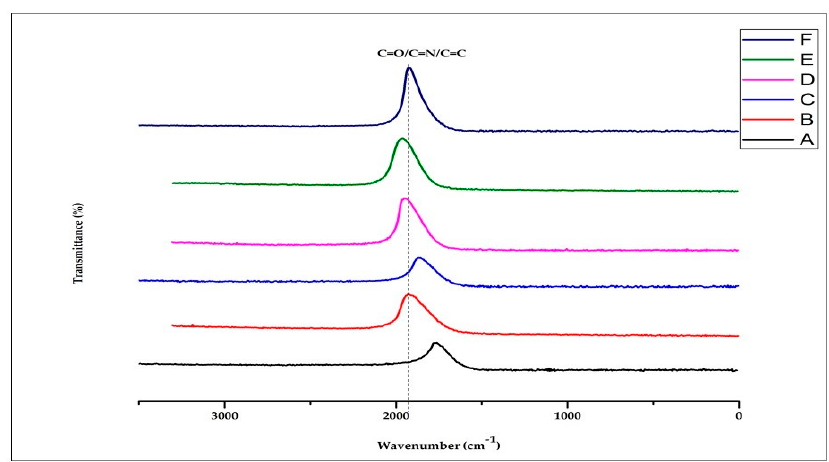
Figure 5. FTIR plot of samples A—92% polylactic acid (P) / 8% chitin (C); B—92% P / 6% C / 2% starch (S); C—92% P / 4% C / 4% S; D—92% P / 2% C / 6% S; E—92% P / 8% S; F—100% P.